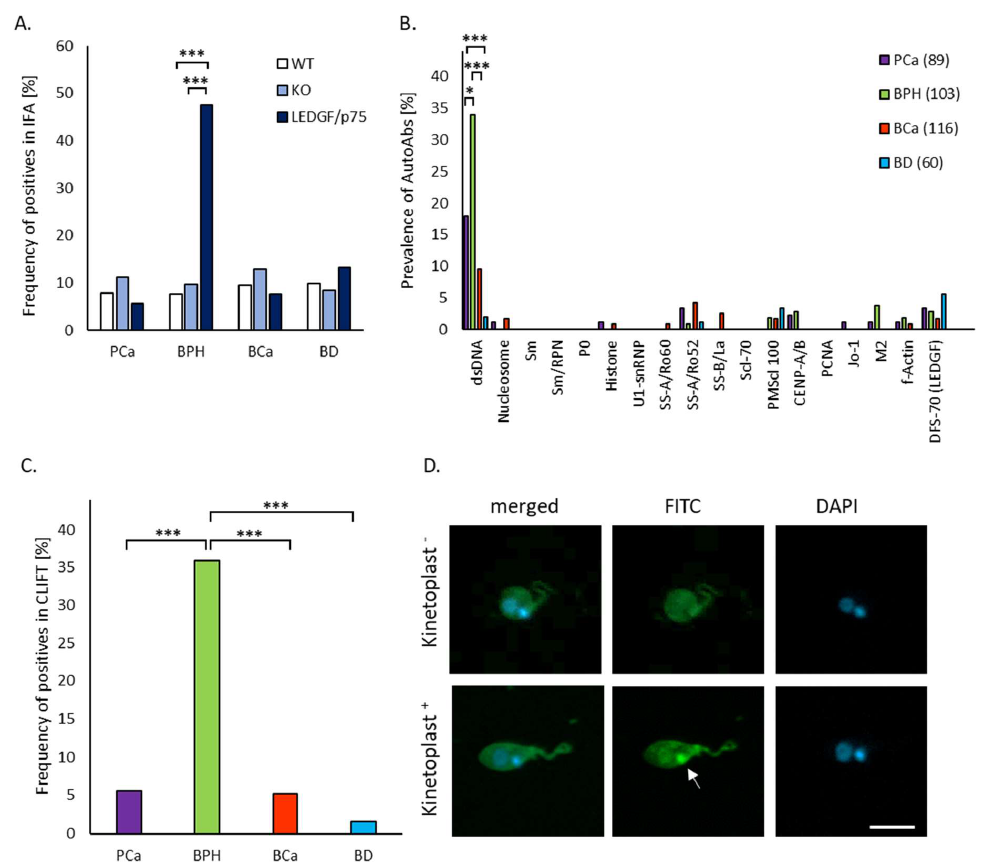
Figure 3. Autoantibodies (autoAbs) in patients and blood donors (BD) detected by indirect immu- nofluorescence assay (IFA) on wild-type (WT), LEDGF/p75 knock-out (KO), LEDGF/p75 over-ex- pressing (OE) HEp-2 cells, and line immunoassay (LIA) as well as Crithidia luciliae immunofluores- cence test (CLIFT). Sera from 60 BD, patients with prostate cancer (PCa) (n = 89), with benign pros- tate hyperplasia (BPH) (n = 103), and bladder cancer (BCa) (n = 116) were run ( A ). In IFA to analyze the overall rate of positives on WT, LEDGF/p75 KO, and LEDGF/p75 OE HEp-2 cells, ( B ) In LIA to detect autoAbs to 18 distinct autoantigens and ( C ). In IFA on Crithidia luciliae to ascertain autoAbs to mDNA. ( D ) Representative fluorescent images of anti-mitochondrial DNA (mDNA) autoAb-neg- ative and positive sera in IFA using DAPI (blue color) to stain DNA and anti-human IgG-FITC (green color) to identify the binding of autoAbs. A positive anti-mDNA autoAb finding requires the staining of the kinetoplast (arrow) (kinetoplast+), which contains mDNA with distinct epitopes not present in the nucleus. Scale bar = 10 µm. * = p < 0.05, *** = p < 0.001 .